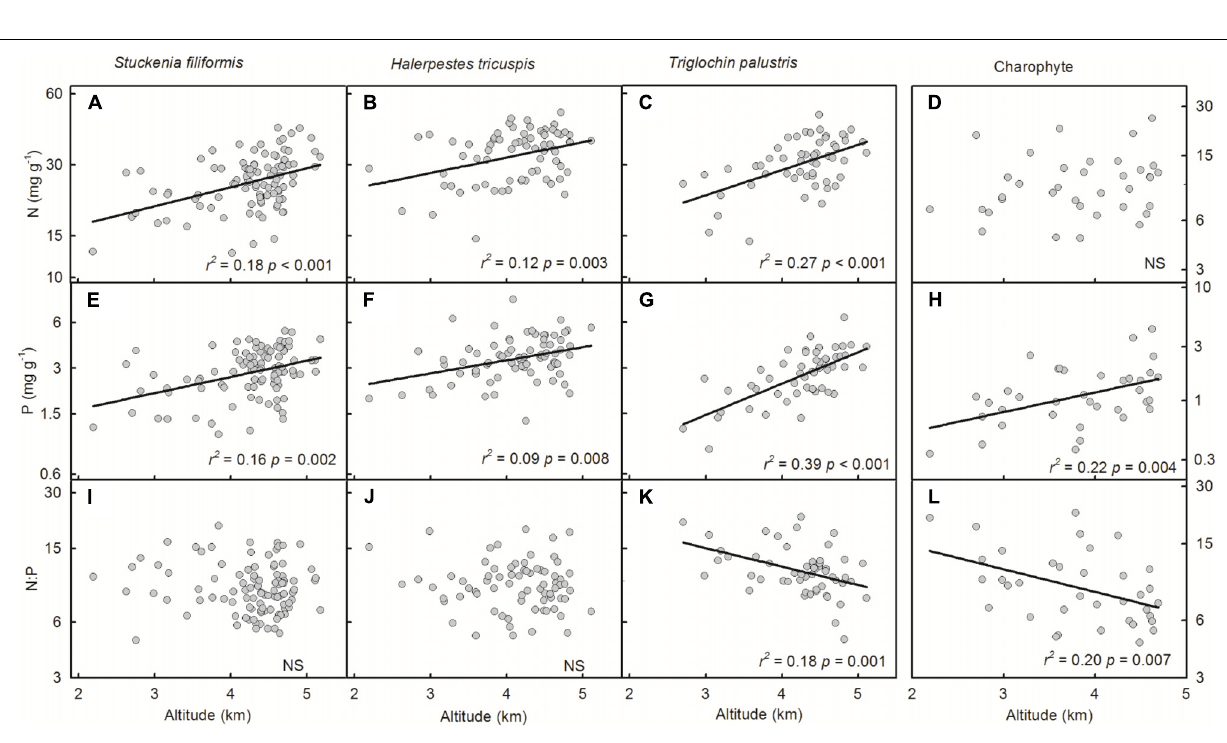
Frontiers in Plant Science |